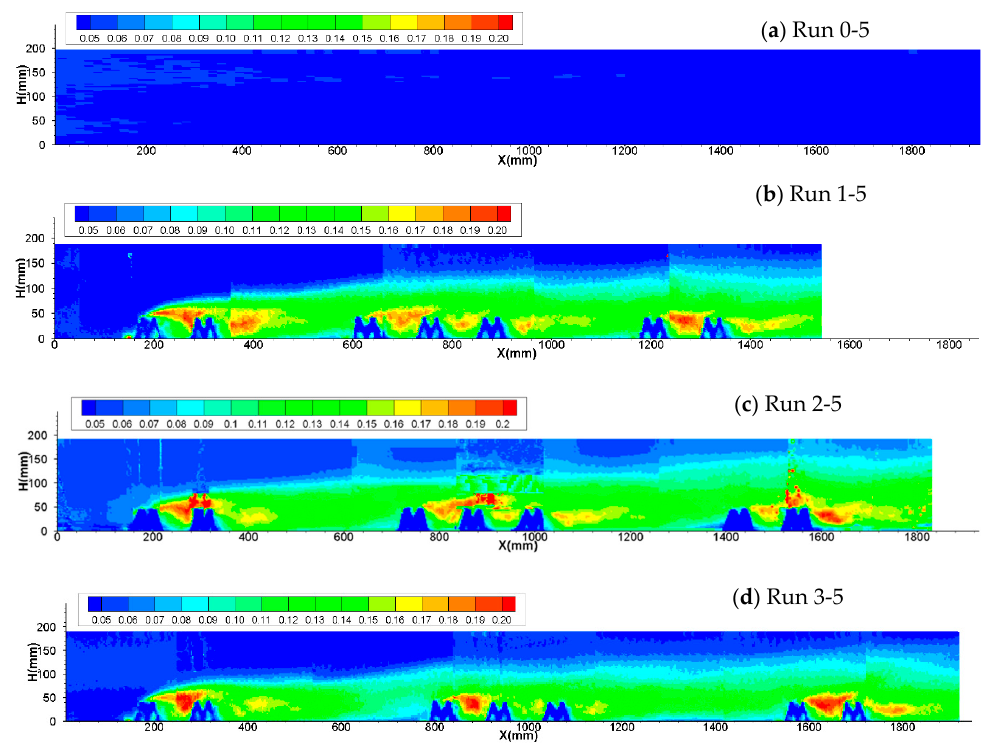
Figure 7. Vertical turbulence intensity for cases 0-5, 1-5, 2-5, and 3-5.